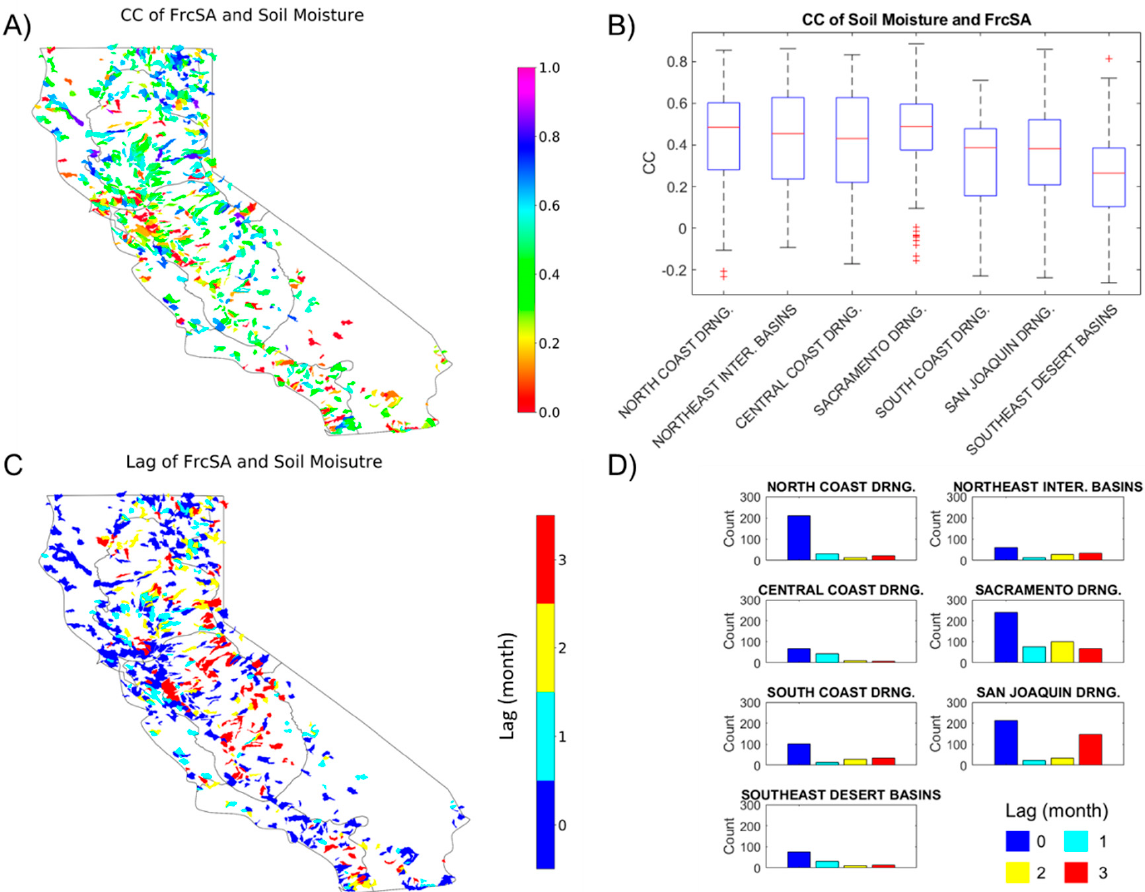
Figure 9. ( A ) Optimal lagged correlations of soil moisture and FrcSA for contributing catchments, ( B ) boxplots of the optimal correlations in the seven climate divisions, ( C ) the corresponding optimal lag ranging from 0 to 3 months and ( D ) histogram of optimal lags in the seven climate divisions .